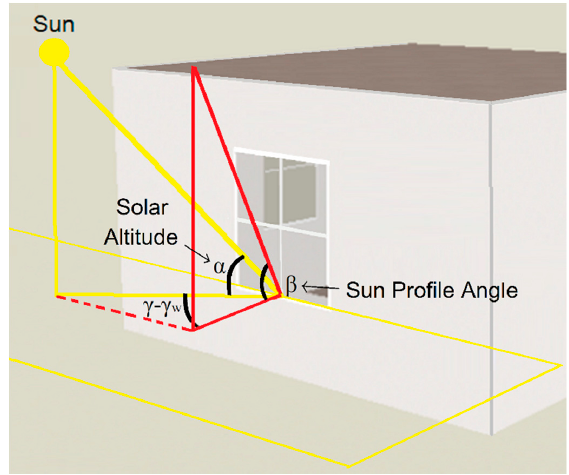
Figure 2. Relationship between sun profile angle, solar azimuth angle and solar altitude angle.